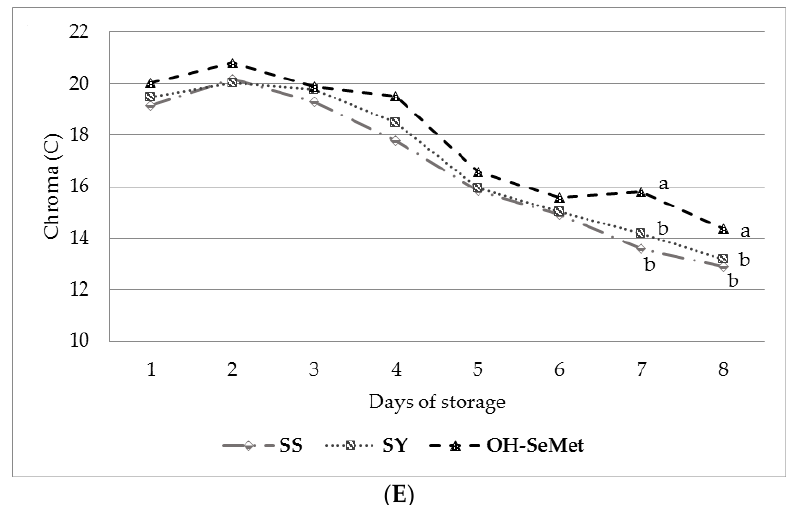
Figure 2. Effect of the selenium source on the lightness (L*) ( A ), redness (a*) ( B ), yellowness (b*) ( C ), hue angle (h) ( D ) and chroma (C) ( E ) of the meat during 8 days of storage. SS—sodium selenite; SY—selenium-enriched yeast; OH-SeMet—hydroxy-selenomethionine. Mean values with different letters are statistically different ( p < 0.05).